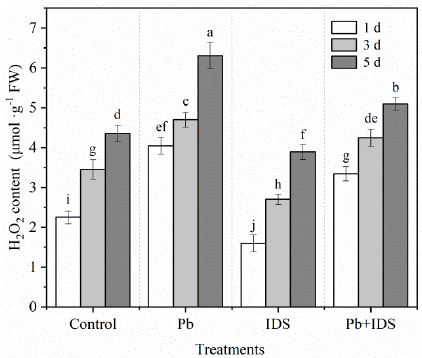
Figure 7. Effects of Pb, IDS, and Pb+IDS on the H 2 O 2 content of maize seeds. Maize seeds treated with distilled water (control), Pb (20 mmol · dm − 3 PbCl 2 ), IDS (100 mmol · dm − 3 ), or Pb+IDS were used, and their H 2 O 2 contents were measured 1, 3, and 5 d after sowing. Error bars represent the standard deviation of the mean ( n = 5). Means associated with different letters are significantly different among treatments and time points ( p < 0.05; Duncan’s new multiple range test). Pb, lead; IDS, imi- nodisuccinic acid; FW, fresh weight.